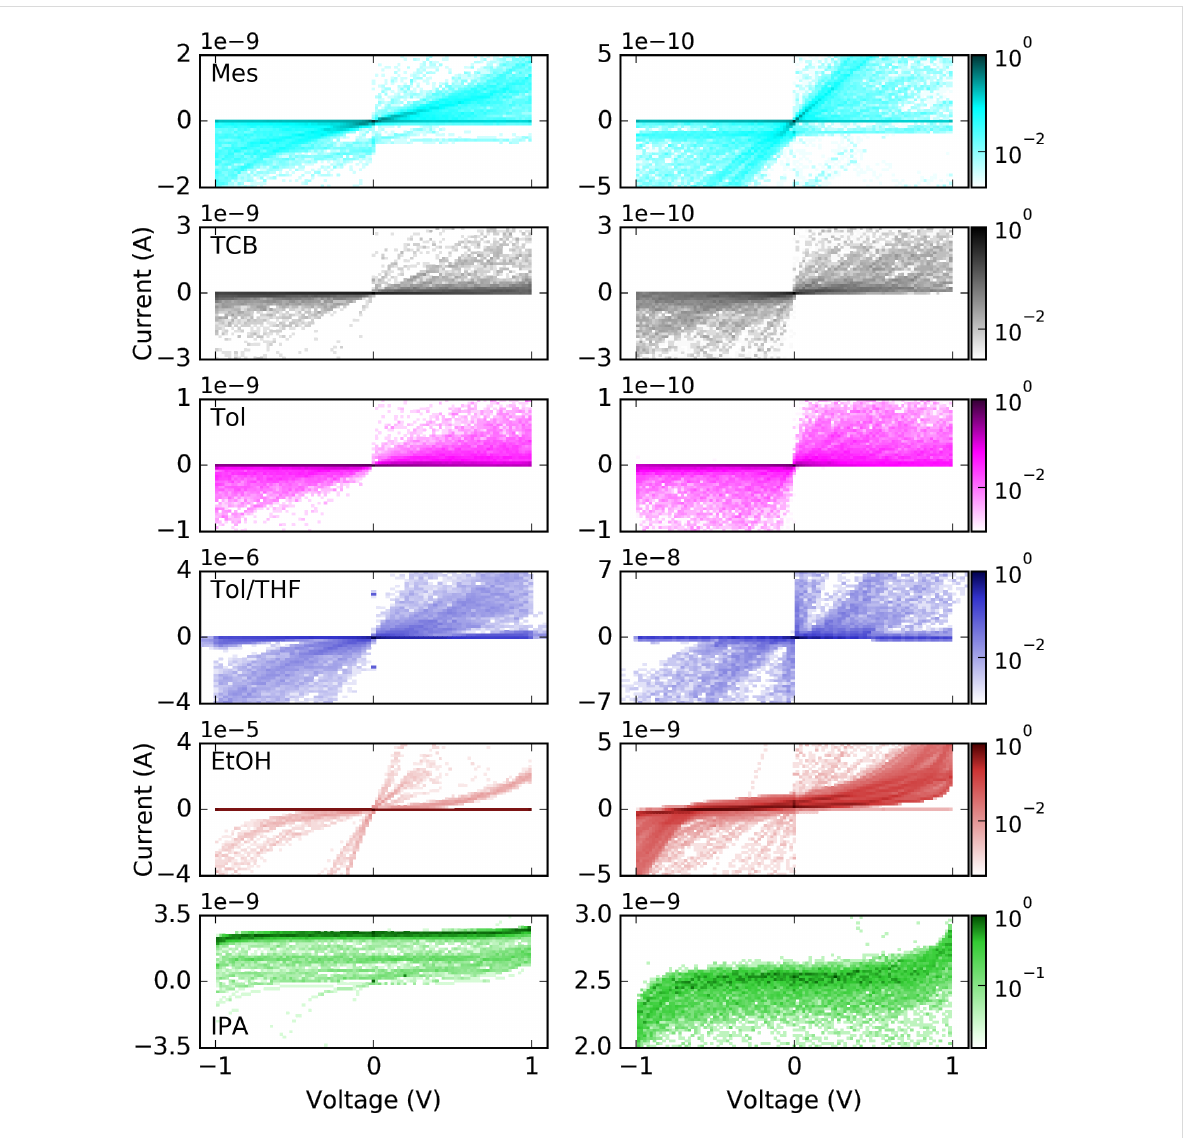
Figure 3: Density plots of current–voltage characteristics of all investigated solvents. The right column gives a close up for the small current region. The colour code is normalized. The total numbers of curves are: Mes 107, TCB 70, Tol 173, Tol/THF 180, EtOH 372, IPA 55. Note different scales for current axes.